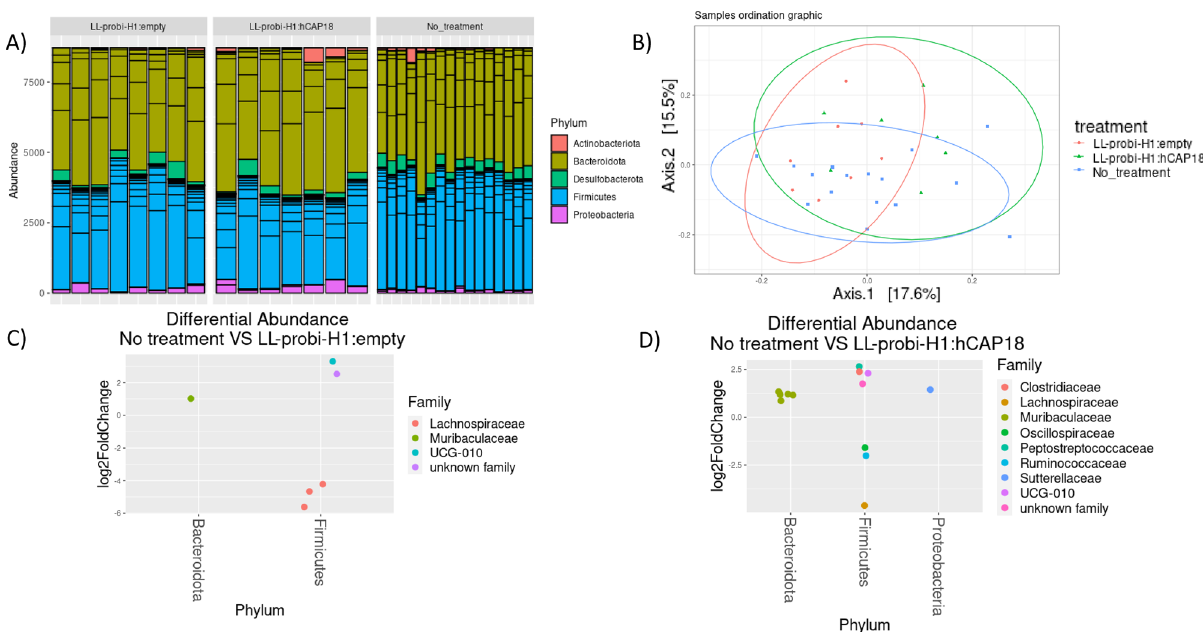
Figure 5. Analysis of the composition of fecal microbiota by 16S sequencing after 7 days of gavage. ( A ) Composition of samples by phylum. ( B ) Principal coordinates analysis of different treatment groups. ( C ) Differentially abundant taxa between untreated and LL-probi-H1:hCAP18 groups and ( D ) untreated and LL-probi-H1:empty groups, according to DESeq2. Untreated control group n = 16, LL-Probi-H1:hCAP18 n = 7, LL-Probi-H1:empty n =